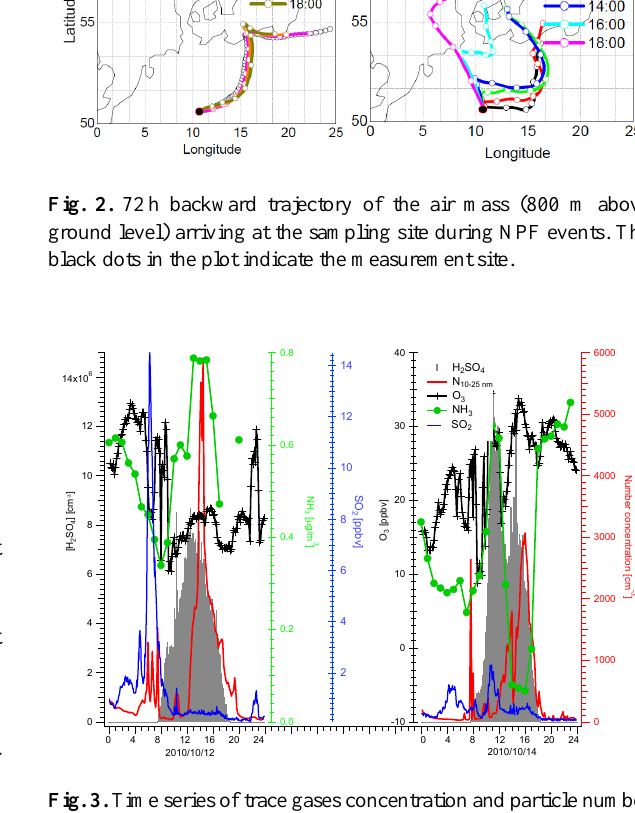
Fig. 3: Time series of trace gases concentration and particle number concentration of 710 Fig. 3. Time series of trace gases concentration and particle number concentration of nuclei mode on NPF